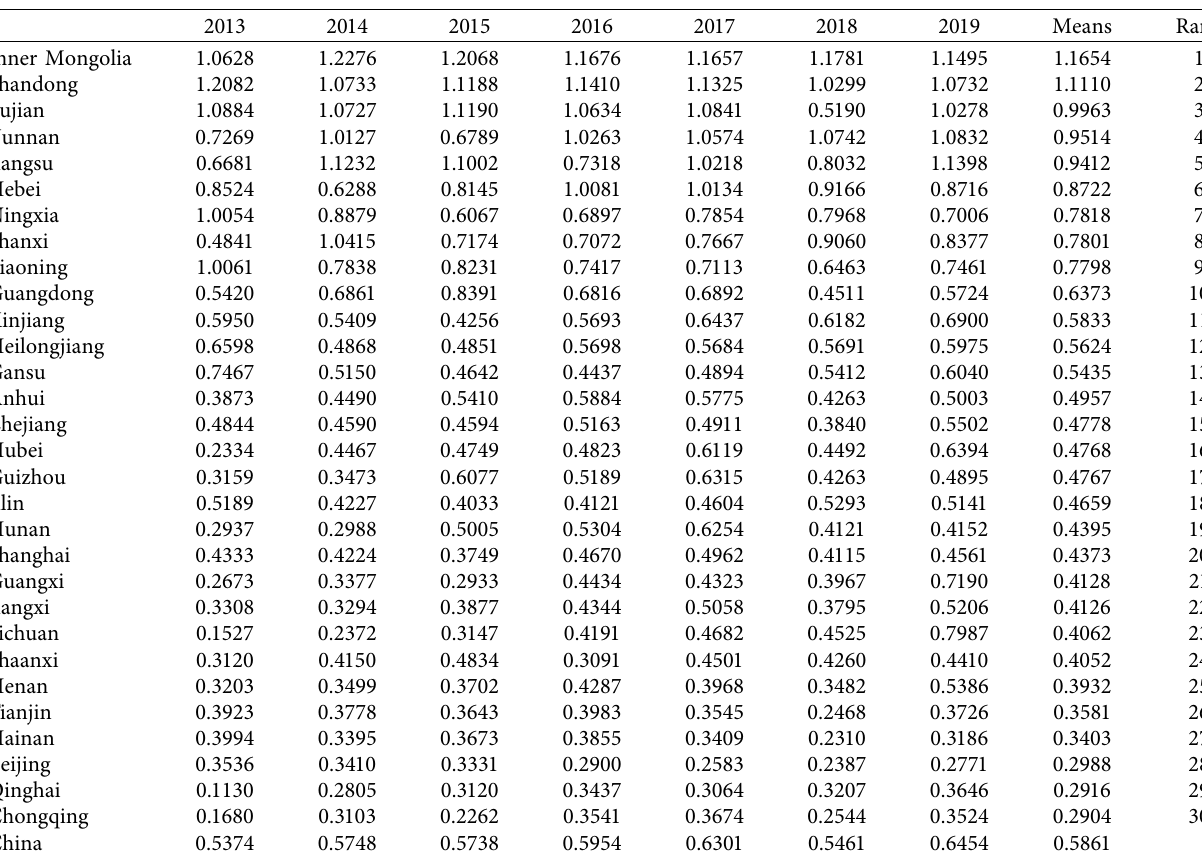
Figure 4: The development trend of wind power utilization efficiency in six regions in China. Table 2: Wind power utilization efficiency of 30 provinces